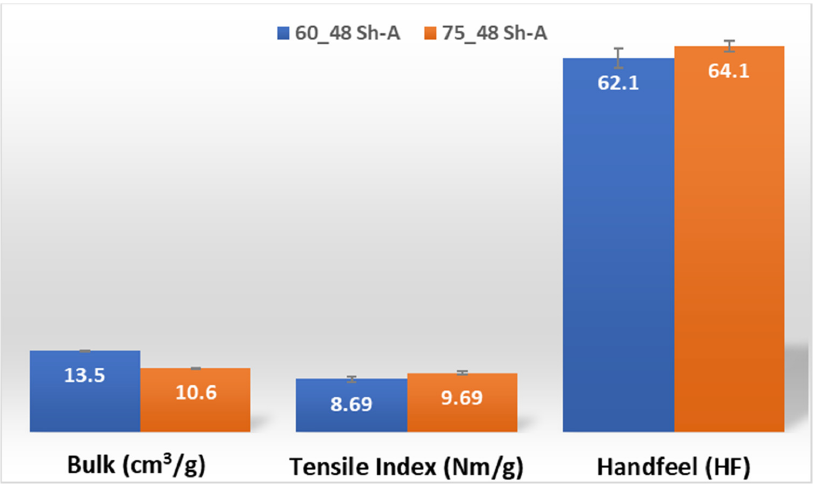
Figure 12. Bulk, tensile index, and handfeel results for micro embossing and configuration 2 rubber hardness conjugation.